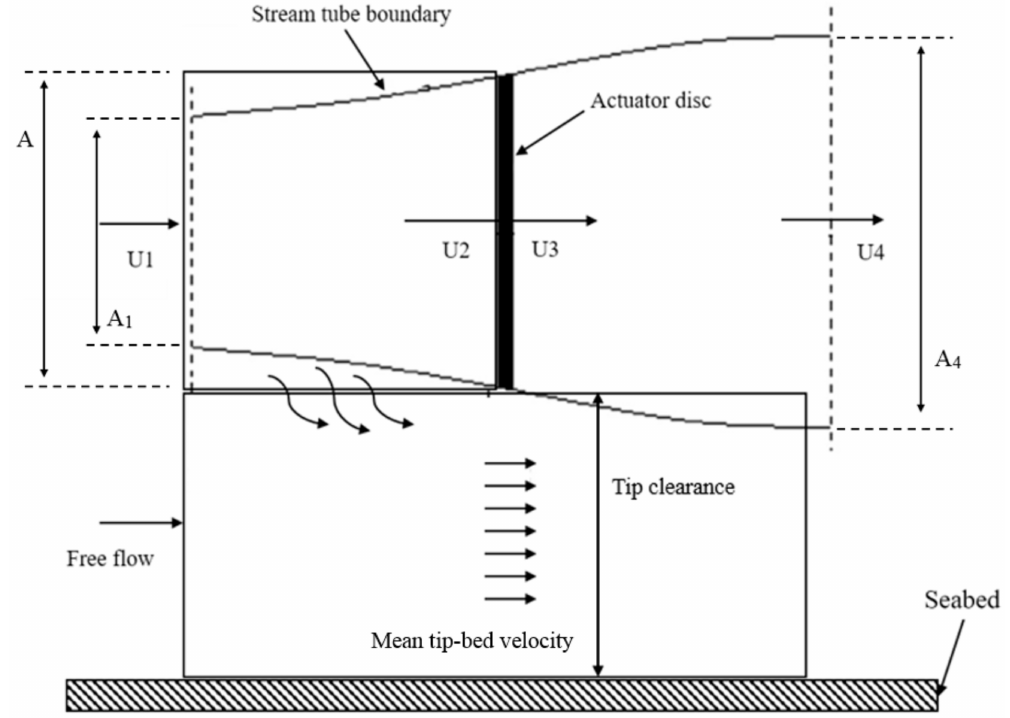
Figure 2. Squeezing process of the tip-bed velocity in